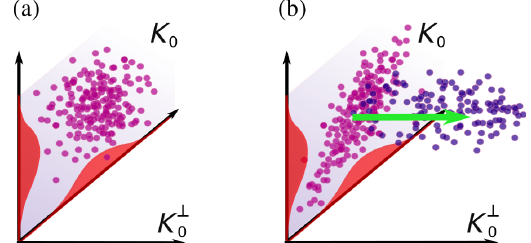
FIG. 8. Generic behavior of disorder probability under RG. Every point is a disorder realization (Hamiltonian). The shaded plane K 0 spanned by axes perpendicular to K ⊥ 0 represents the subspace of two-body nearest-neighbor couplings; K ⊥ 0 is the complement space of all other couplings. (a) Initially, a factorized distribution is usually assumed, schematically shown as a product of independent Gaussians. (b) After the RG step, the distribution can develop correlations depicted for simplicity in the K 0 plane, and additional couplings can be generated, resulting in proba- bility mass shift out of K 0 . The former effect is quantified by KL divergence or distance correlation, the latter by the shift of the center of mass of the distribution depicted with a green arrow (see also Fig.